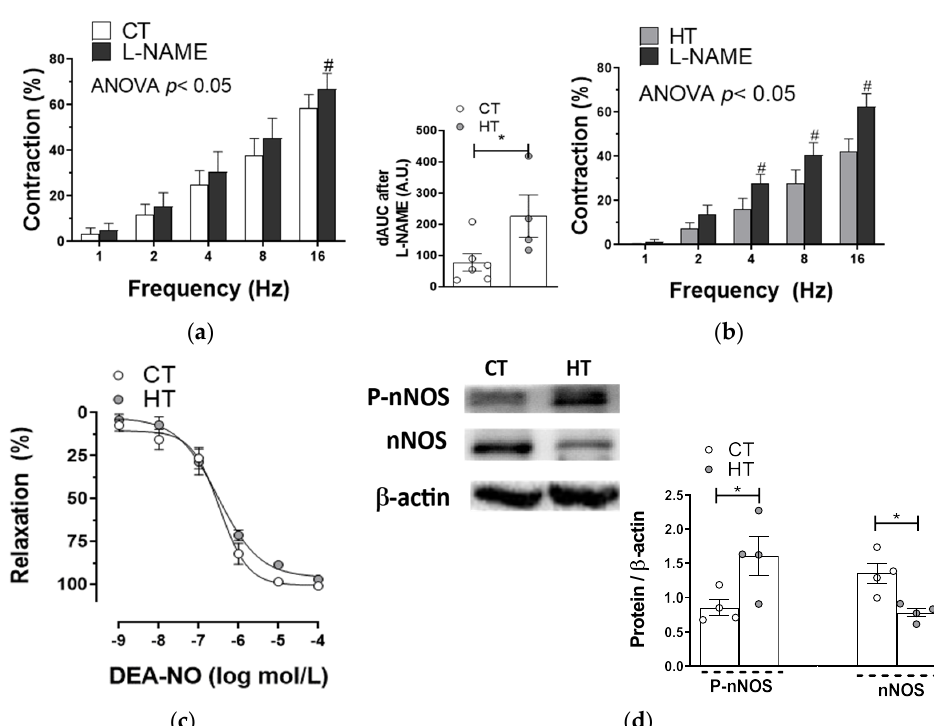
Figure 5. Effect of preincubation with the unspecific nitric oxide synthase (NOS) inhibitor L-NAME on EFS-induced vasoconstriction in mesenteric arteries from control (CT, ( a )) and rats with hyperthy- roidism (HT, ( b )). Results (mean ± S.E.M.) are expressed as a percentage of previous tone induced by KCl. # p < 0.05 conditions without drug vs. L-NAME at each frequency (Bonferroni post hoc test). n = 4–6 segments from different animals in each experimental group. Insert graph represents the differences in the area under the curve (dAUC) in presence/absence of L-NAME. * p < 0.05 CT vs. HT (Student’s t-test). ( c ) Vasodilator response to NO donor DEA-NO in mesenteric segments from CT and HT rats. Results (mean ± S.E.M.) are expressed as a percentage of the previous tone elicited by noradrenaline. n = 5 segments from different animals in each experimental group. ( d ) Expression and phosphorylation on Ser 1417 of nNOS in mesenteric rings from CT and HT rats (4 isolated segments from each group). Lower panels show densitometry analysis for the expression of each protein. Results (mean ± S.E.M.) are expressed as the relation between the signal obtained for the analyzed protein and the signal obtained for β -actin. * p < 0.05 CT vs. HT (Student’s t